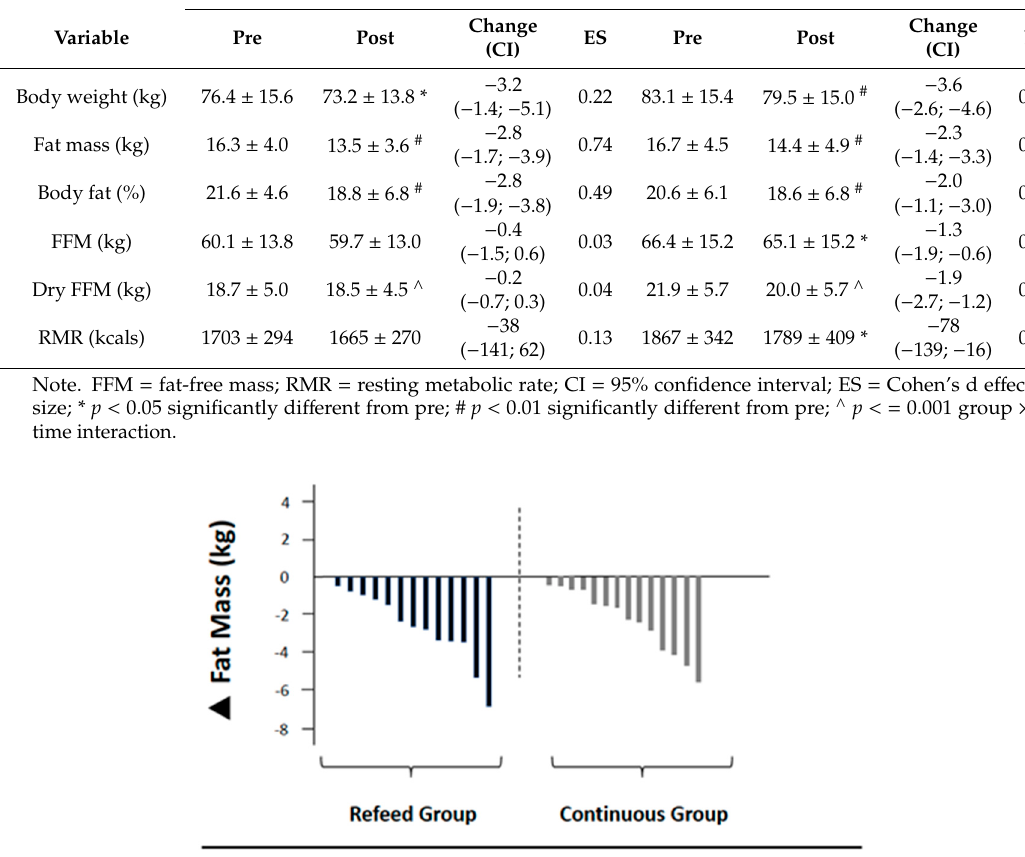
Figure 2. Individual participant changes in fat mass.